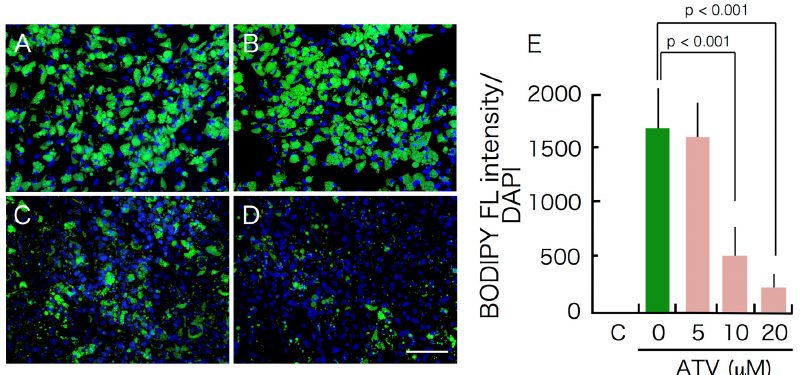
Figure 2. Suppression of adipogenesis-dependent accumulation of lipid droplets by atazanavir (ATV). Adipose tissue-derived stem cells (ADSCs), cultured in serum-free medium until they reached confluence, were incubated in adipogenic differentiation medium for 10 days with varying concentrations of ATV. ( A ) control, ( B ) 5 µ M ATV, ( C ) 10 µ M ATV, and ( D ) 20 µ M ATV. Cells were fixed with 4% formalin and stained with BODIPY 493/503. Images were taken under a fluorescence micro- scope. White scale bar indicates 250 µ m. ( E ) Fluorescence images were taken under a fluorescence microscope and green fluorescence (FL) of BODIPY was divided by the blue fluorescence of DAPI. C, control. Experiments were repeated three times.